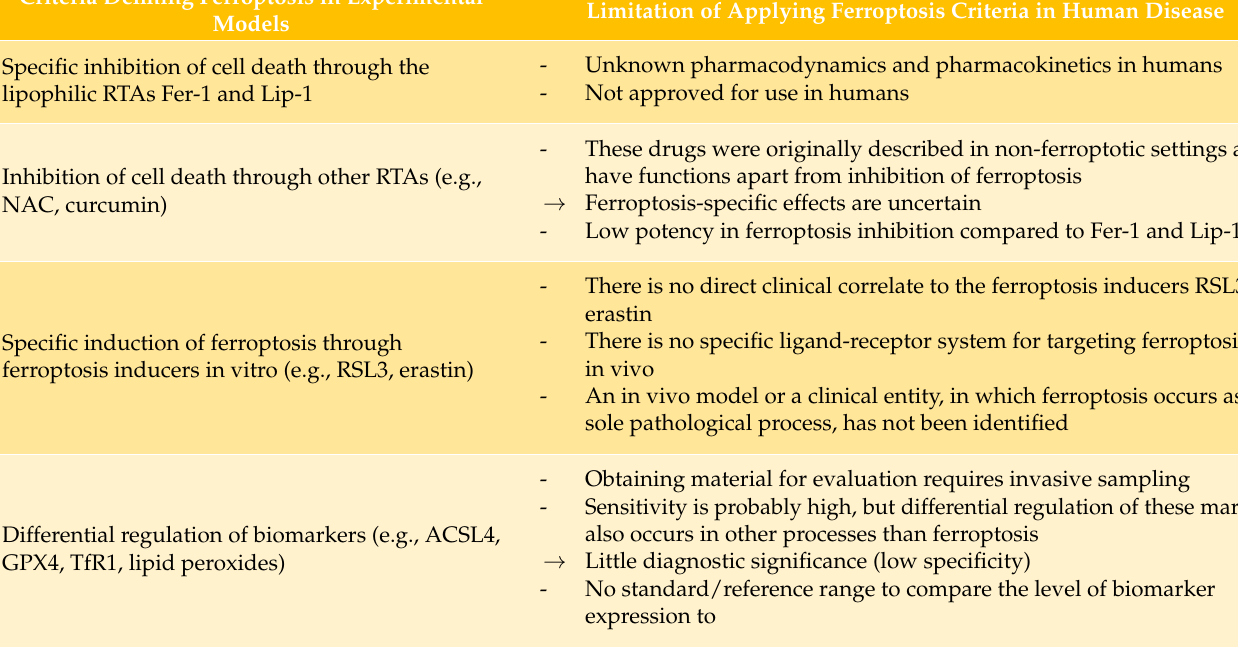
Table 2. Difficulties in translating the in vitro definition of ferroptosis into clinical utility. The left column represents criteria commonly used to detect ferroptosis in vitro or in experimental models. The right column depicts the weaknesses of these criteria in accurately defining ongoing ferroptosis in human disease. Acyl-CoA synthetase long-chain family member 4 (ACSL4), ferrostatin-1